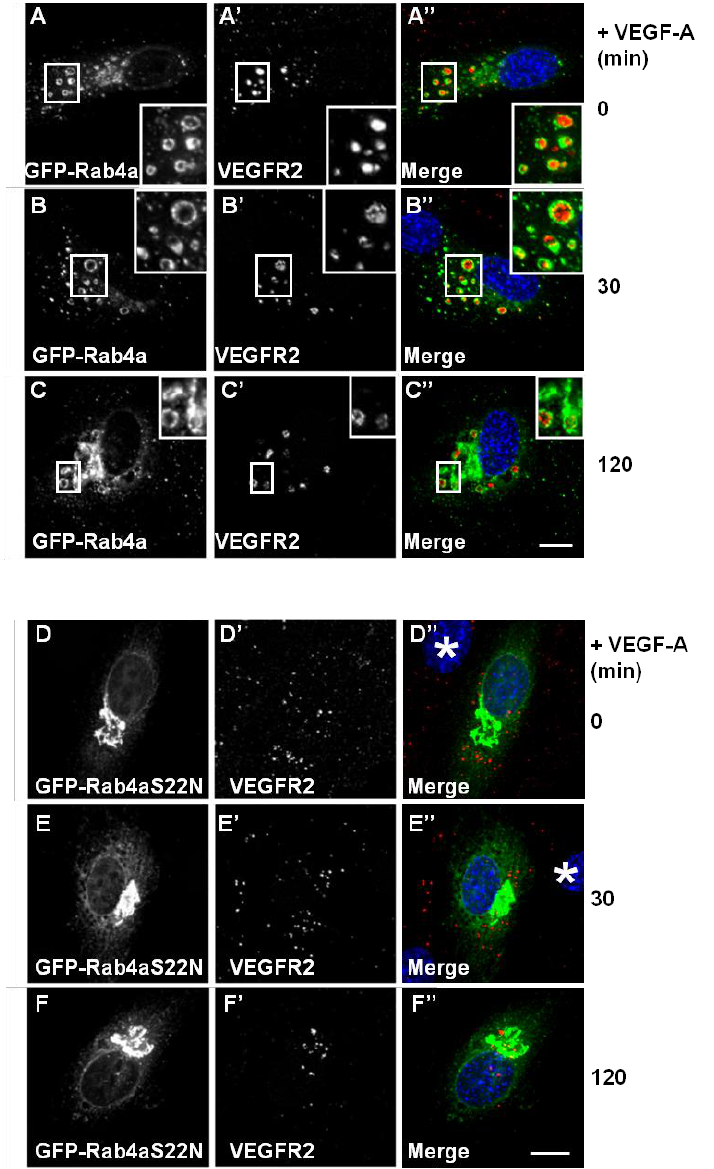
Figure 4. Rab11a perturbation does not affect VEGF-A stimulated VEGFR2